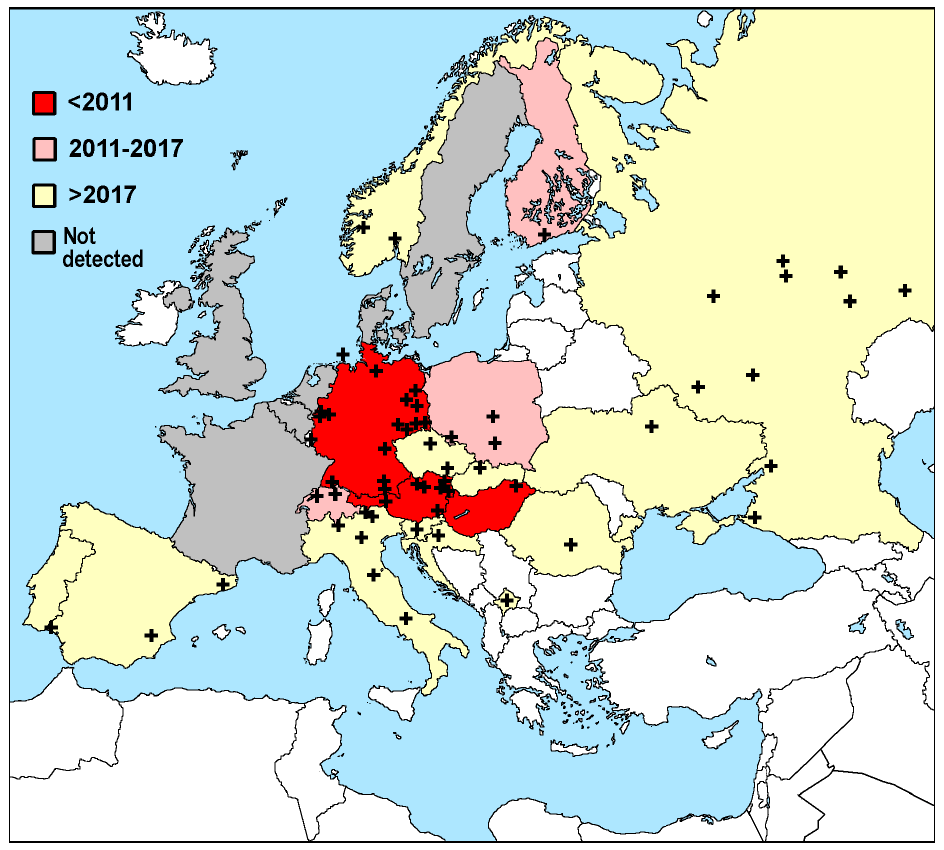
Figure 3. Map of the occurrence of Ctenolepisma calvum in Europe. The year of the first observation in countries is denoted by the shading. Places within countries where the insect was initially found are marked as +. Gray shading denotes countries where traps and observations have not revealed C. calvum (details in Supplement Table S2). White indicates countries, where the species has not yet been found (because of lack of traps, experts, or introduction).